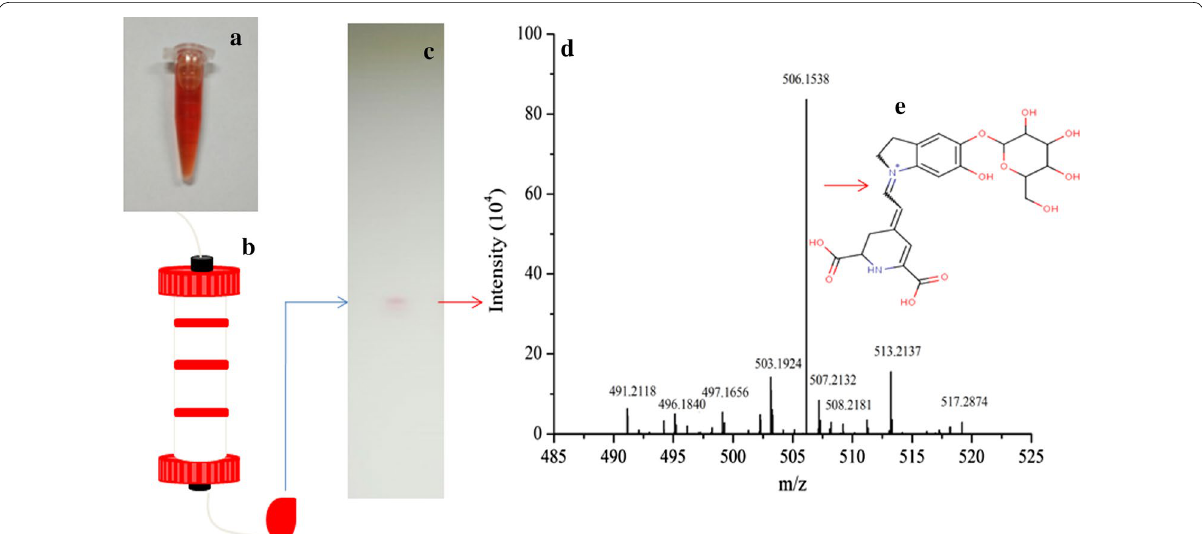
Fig. 3 The preliminary separation and identification of 2-decarboxybetanin. a The pigment solution before separation; b silica gel column chro- matography; c the pigment component analyzed by TLC; d the pigment component identified by high-resolution MS; and e chemical structure of